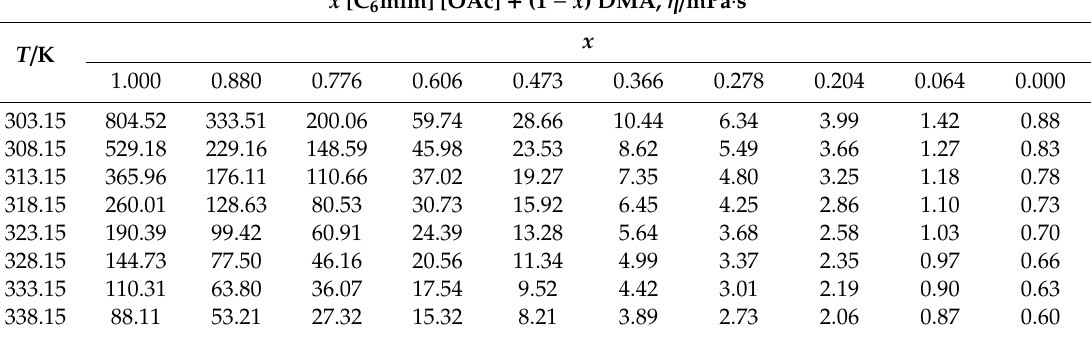
Table 10. Experimental viscosities of [C 6 mim] [OAc] with DMA at (0.0967 ± 0.002) MPa from 303.15 to 338.15 K and x is IL mole fraction.